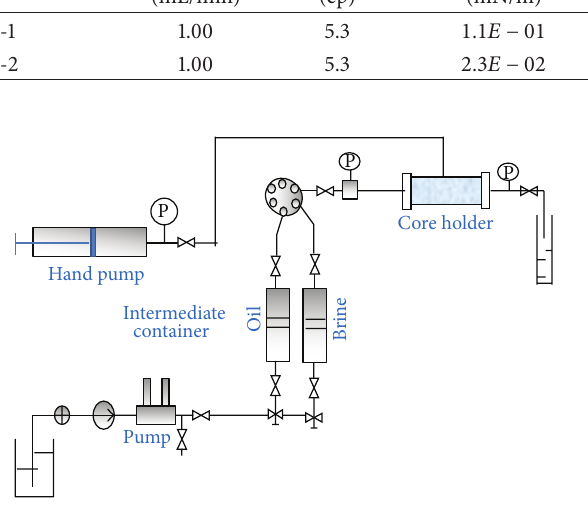
Figure 3: Setups for experimental displacement.